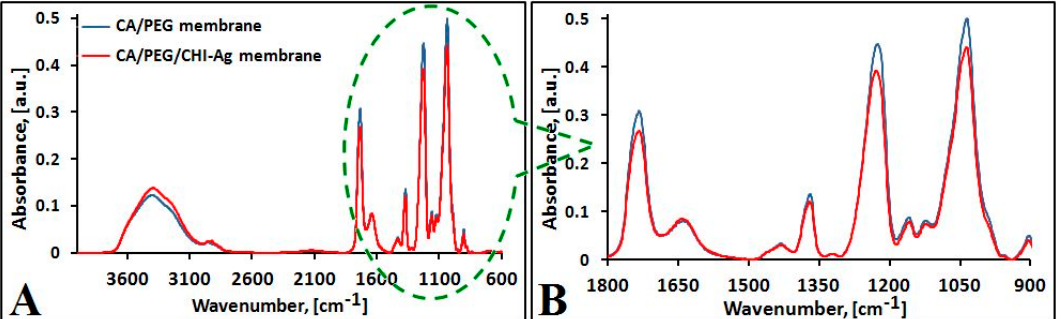
Figure 4. FTIR-ATR spectra of prepared membranes: CA / PEG ( A ) and CA / PEG / CHI-Ag ( B ). FTIR-ATR spectra of polymeric membranes, with and without chitosan (CHI)—silver (Ag) ions,